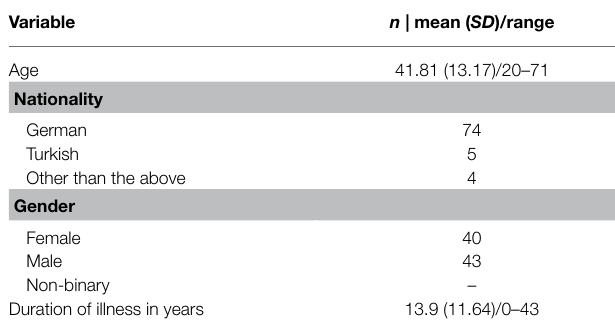
FIGURE 1 | Model summary.